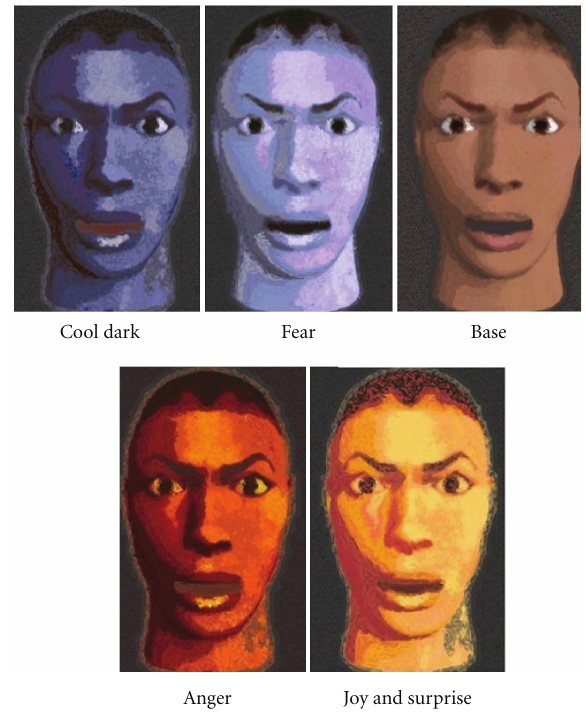
Figure 4: Five-color palettes for basic emotions.